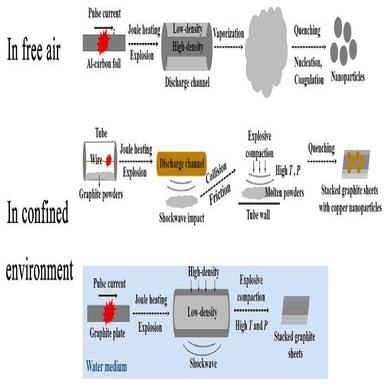
Schematic illustration of the mechanism of product formation in free air and confined environments.